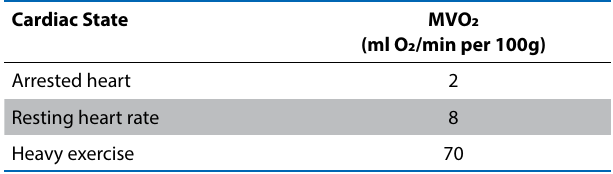
Table l: MVO2 requirements of the heart during different conditions⁹ Cardiac State